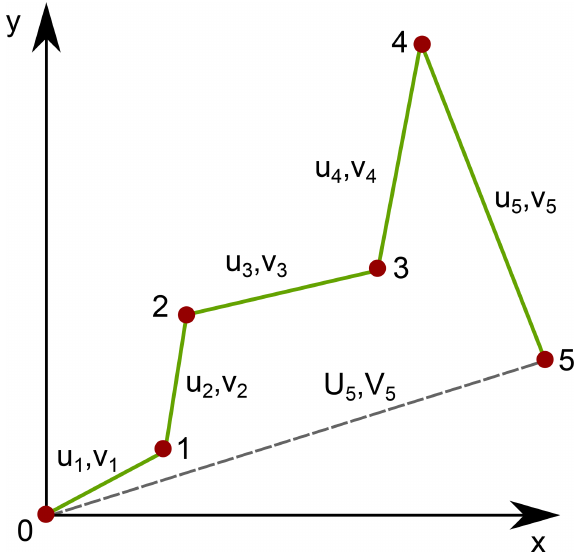
Figure 10. Illustration of incremental and cumulative Lagrangian displacements and track length. Material point (red dot) moves from position 0 to 5. The velocity vectors at time step i are u i ,v i . The cumulative displacements are U i ,V i (dashed line). The track length is the length of the path: the length of the green